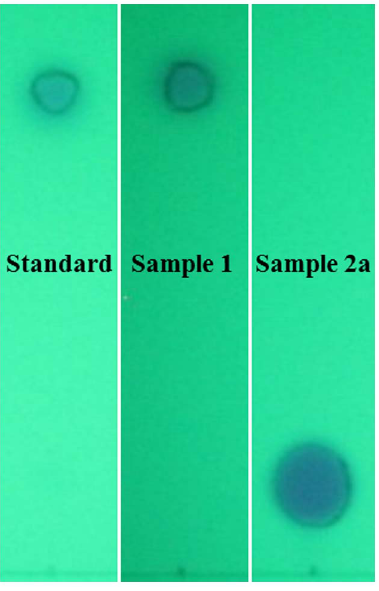
Figure 1. TLC analysis. Results for a levonorgestrel standard, sample 1 (positive control), and sample 2a observed under 254 nm light.